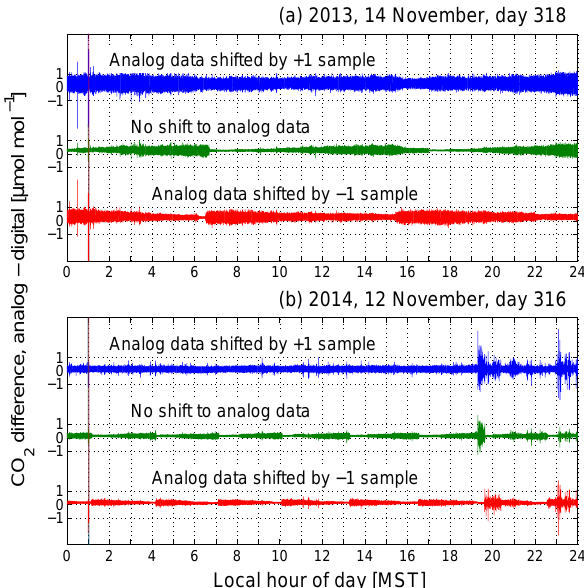
Figure 8. A time series of the difference between the 10Hz analog EC155 CO 2 measured by the US-NR1 data system and the 10Hz digital EC155 CO 2 data saved on the CR3000 for (a) 14 Novem- ber 2013 and (b) 12 November 2014. The differences are shown where the analog samples have been shifted by one sample forward and backward in time as described by the text above the time series.